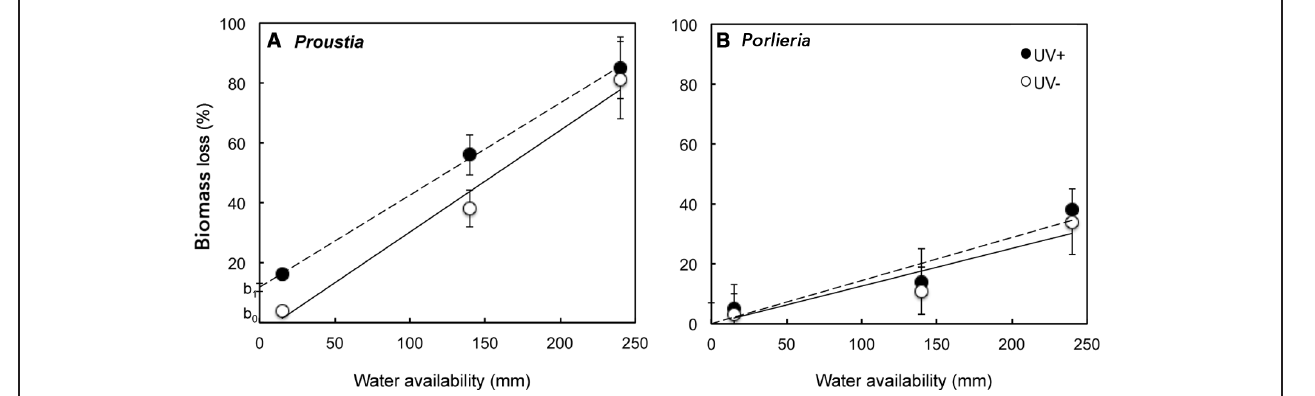
FIGURE 3 | Graphic representation of carry-over effects of photodecomposition on litter biomass losses (%) as a function of water availability for two shrub species with contrasting leaf traits. (A) Carry-over effects of UV exposure during the dry summer months promoted further carbon losses from Proustia litter, particularly in the irrigation treatments equivalent to low and average rainfall years, (B) No significant effects of